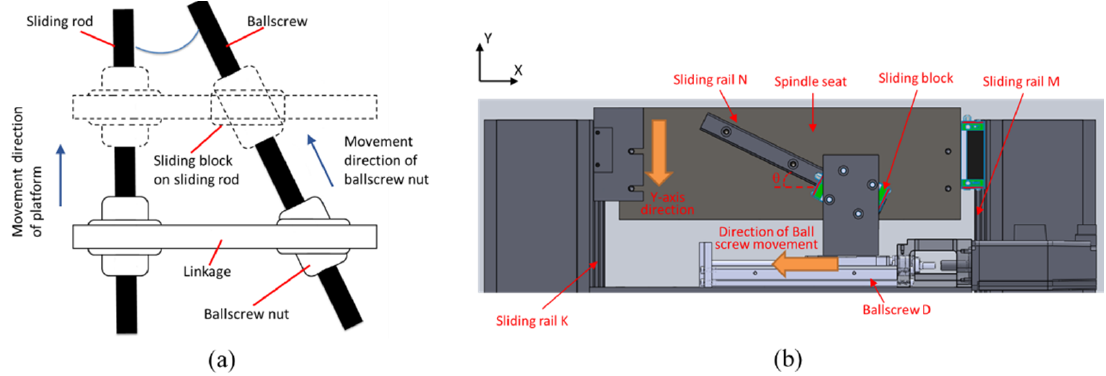
Figure 2. ( a ) Tilt-servo mechanism principle, ( b ) spindle seat with tilt-servo mechanism.